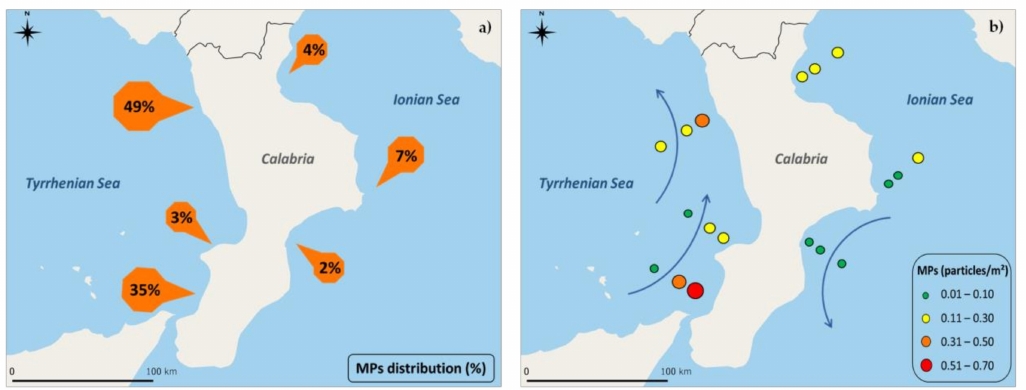
Figure 6. ( a ) Map of the Calabrian coasts showing the location of sampling stations and the distribution of plastic densities expressed as percentages; ( b ) microplastics’ density at different sampling distances from the coast (0.5, 1.5, 6 nautical miles) in the 6 Calabrian sampling sites; blue arrows represent ocean